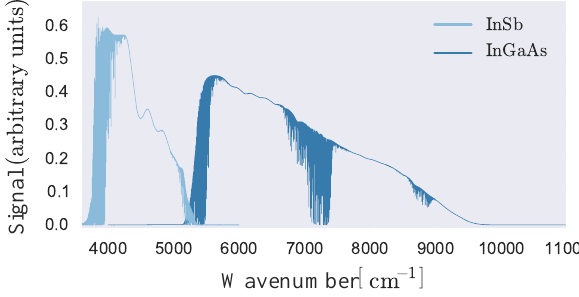
Figure A2. Karlsruhe black-body cavity spectra recorded at 1000 ◦ C by the InSb and InGaAs